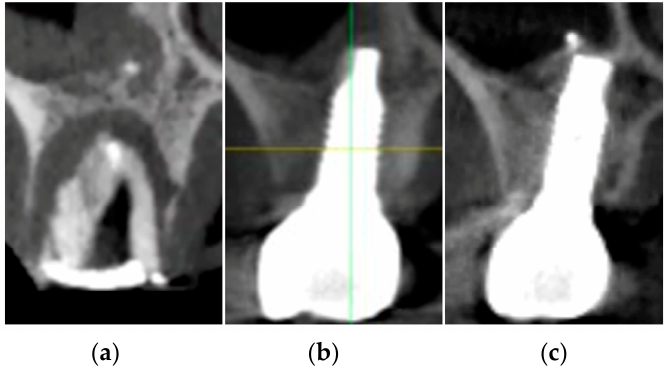
Figure 4. Cross-sectional images: preoperative ( a ); post-surgical at 4 months ( b ); and at 1 year ( c